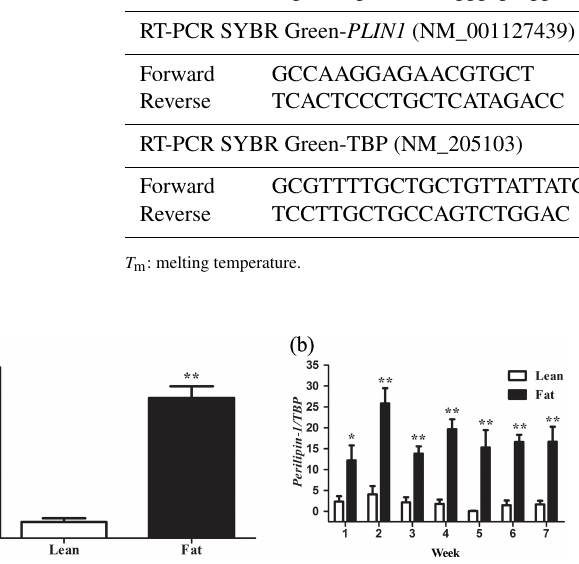
Figure 1. PLIN1 expression in NEAUHLF abdominal adipose tis- sues. The mRNA levels were determined by real-time quantitative reverse-transcription polymerase chain reaction and normalized to TATA-box binding protein ( TBP ) mRNA measured in parallel ex- periments. Results are the mean ± SE. (a) Mean PLIN1 expression in adipose tissues of lean and fat broilers ( n = 35). (b) Mean PLIN1 expression in adipose tissues of lean and fat broilers at 1–7 weeks of age ( n = 5). ∗ P < 0 . 05 and ∗∗ P < 0 .